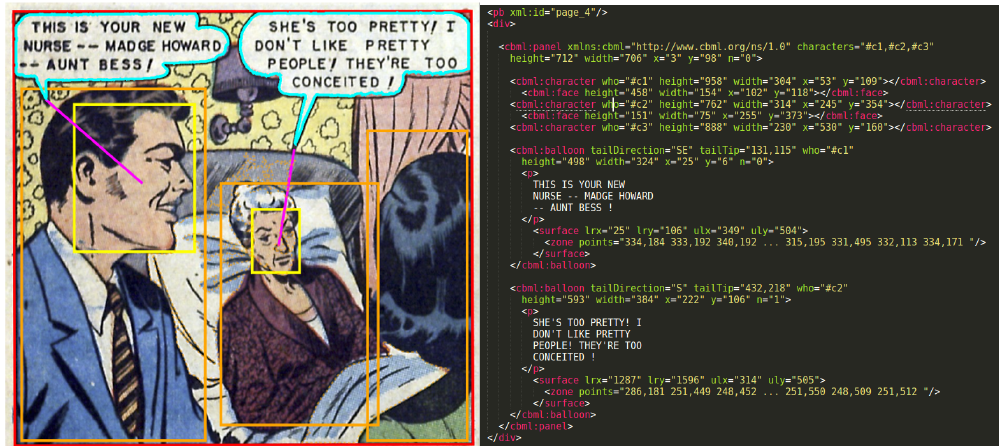
Figure 1. In the left part, an example of recognized elements and its connections with the corresponding description file that we propose to generate. Recognized elements are highlighted in the image by a colored contour: red for the panel, cyan for the balloons, orange for the characters, yellow for the faces and magenta for the links between balloons and faces. In the right part, an extract of the corresponding description file following the Comic Book Markup Language (CBML) and encoding positions and relations of all recognized